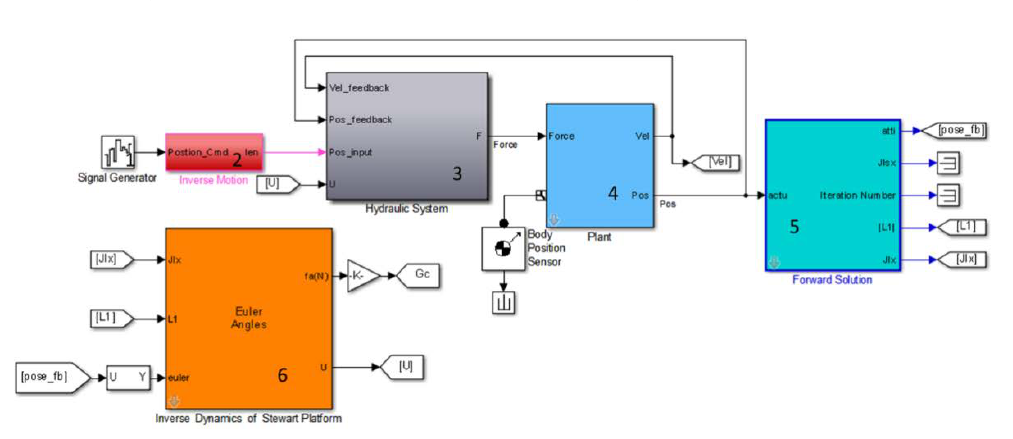
Table 1. Parameters of the hydraulic system of the simulation model.